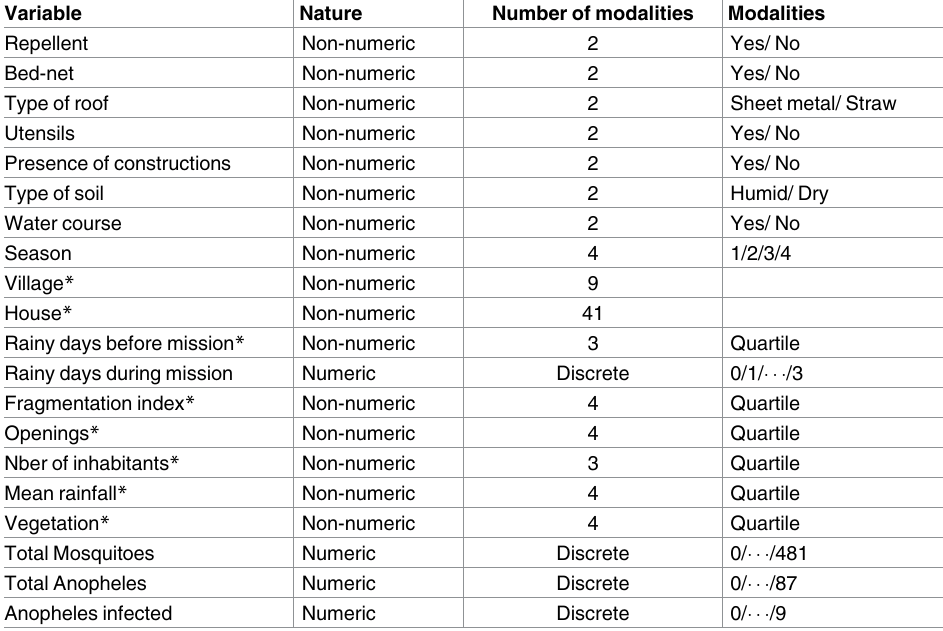
Table 2. Description of recoded variables. Variableswith star are